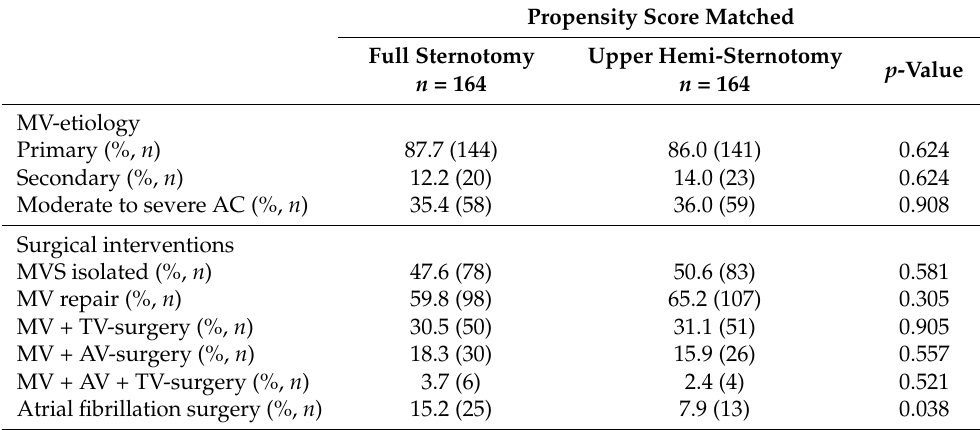
Table 2. Intraoperative parameters after propensity score